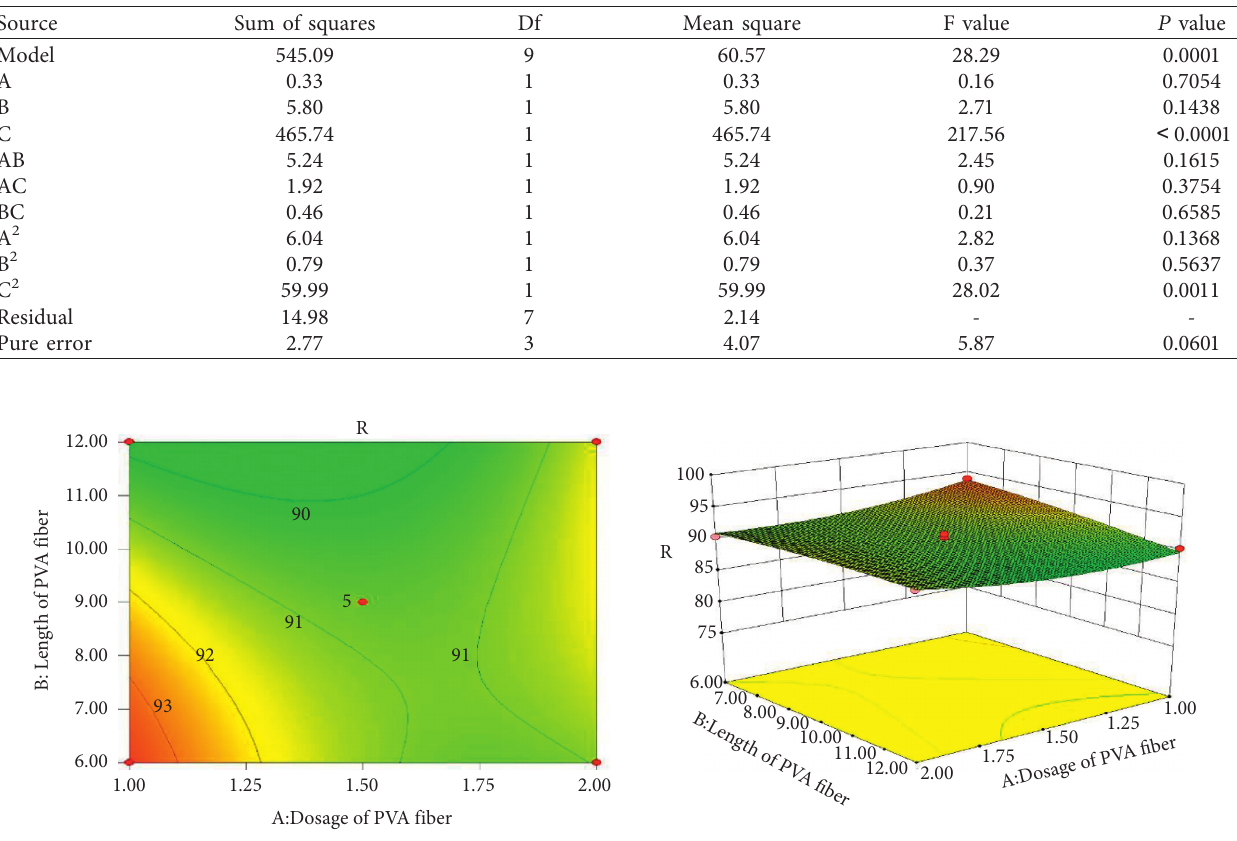
Figure 4: The effect of the interaction of A and B on R.